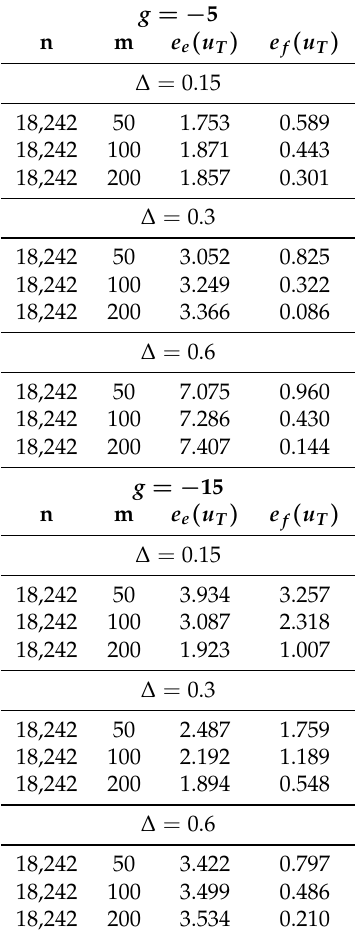
Table 8. Geometry with the unstructured grid with h-smoothing. Relative L 2 error for the temperature at the final time and phase change interface location with respect to the exact solution and a very fine grid solution. g = − 5 n